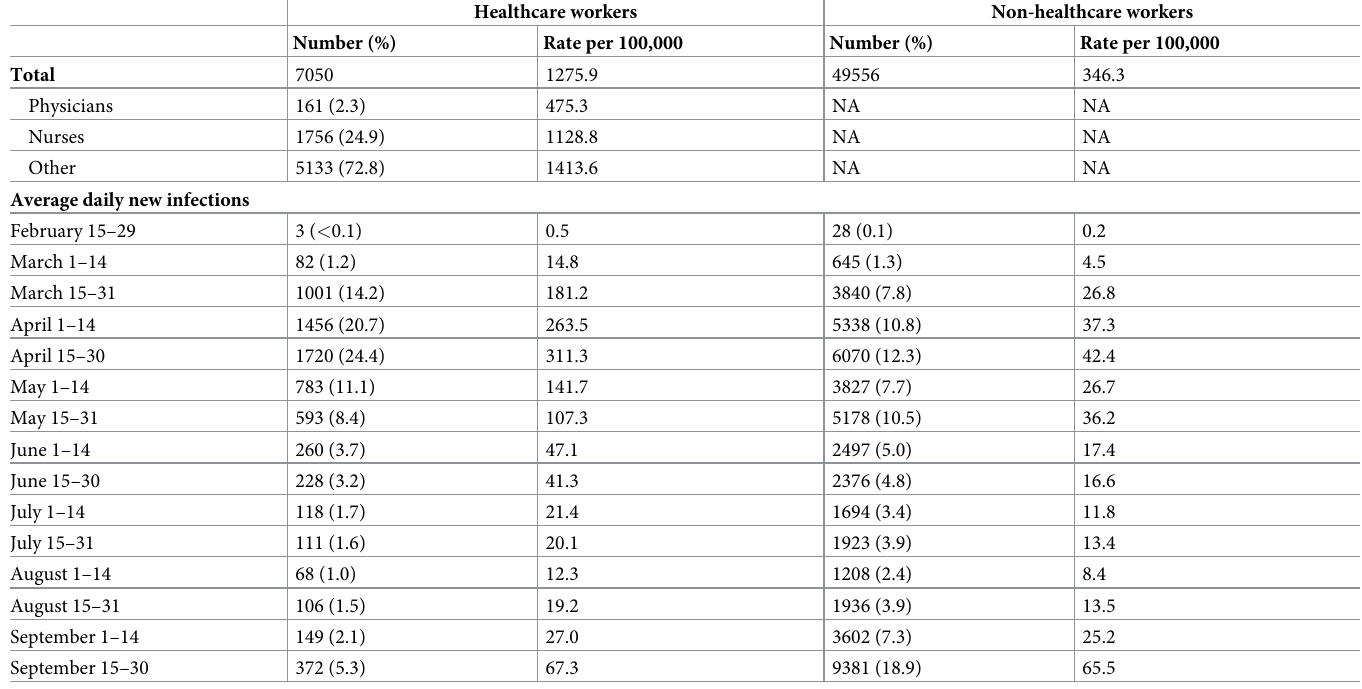
Table 2. Rate of new SARS-CoV-2 infections in healthcare workers and non-healthcare workers. Healthcare workers Non-healthcare